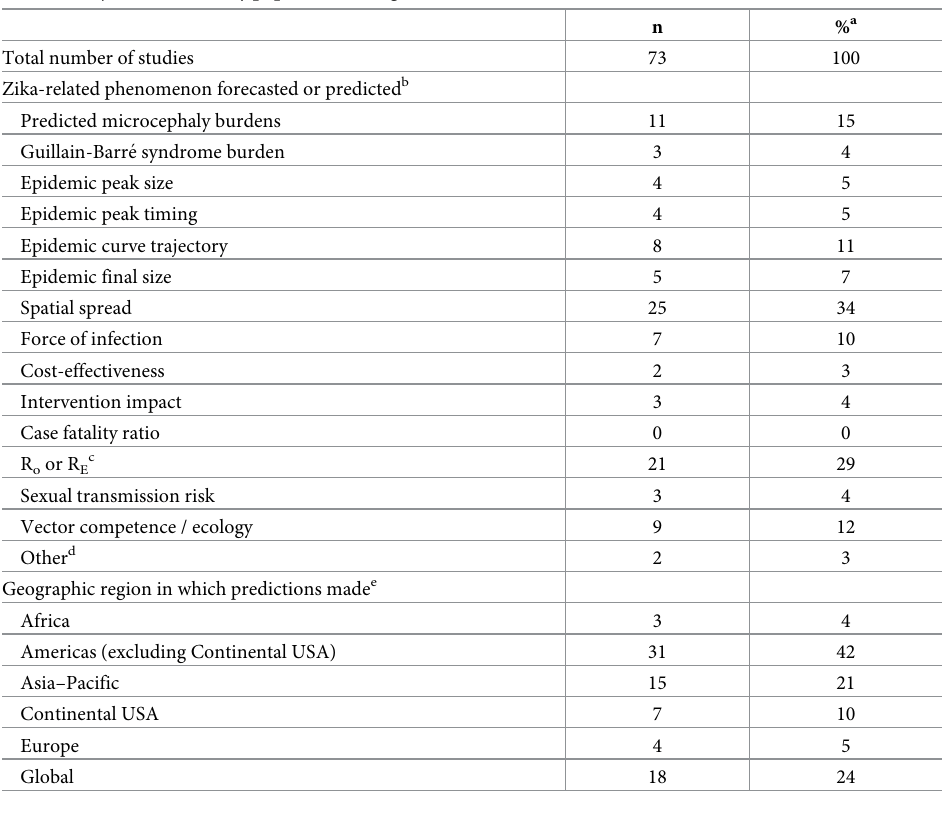
Table 1. Objectives and study population of eligible studies.